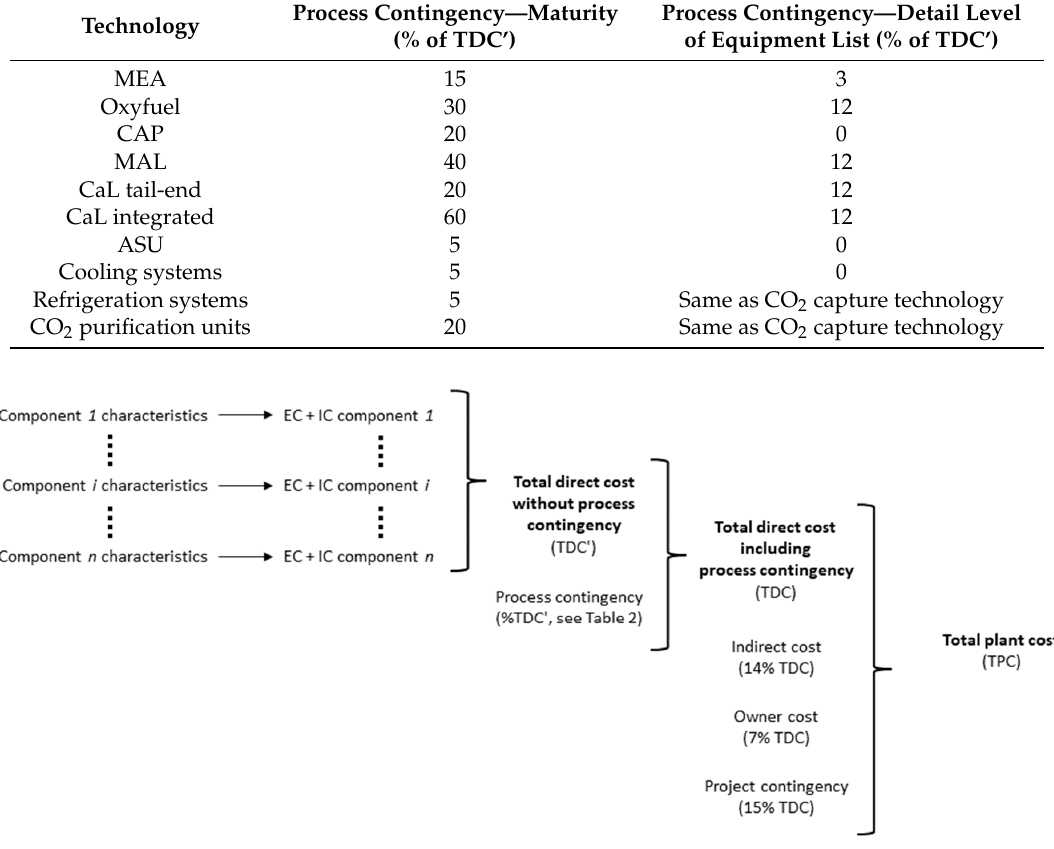
Figure 3. Break-down of cost elements in the bottom-up approach for estimation of total plant costs [35].